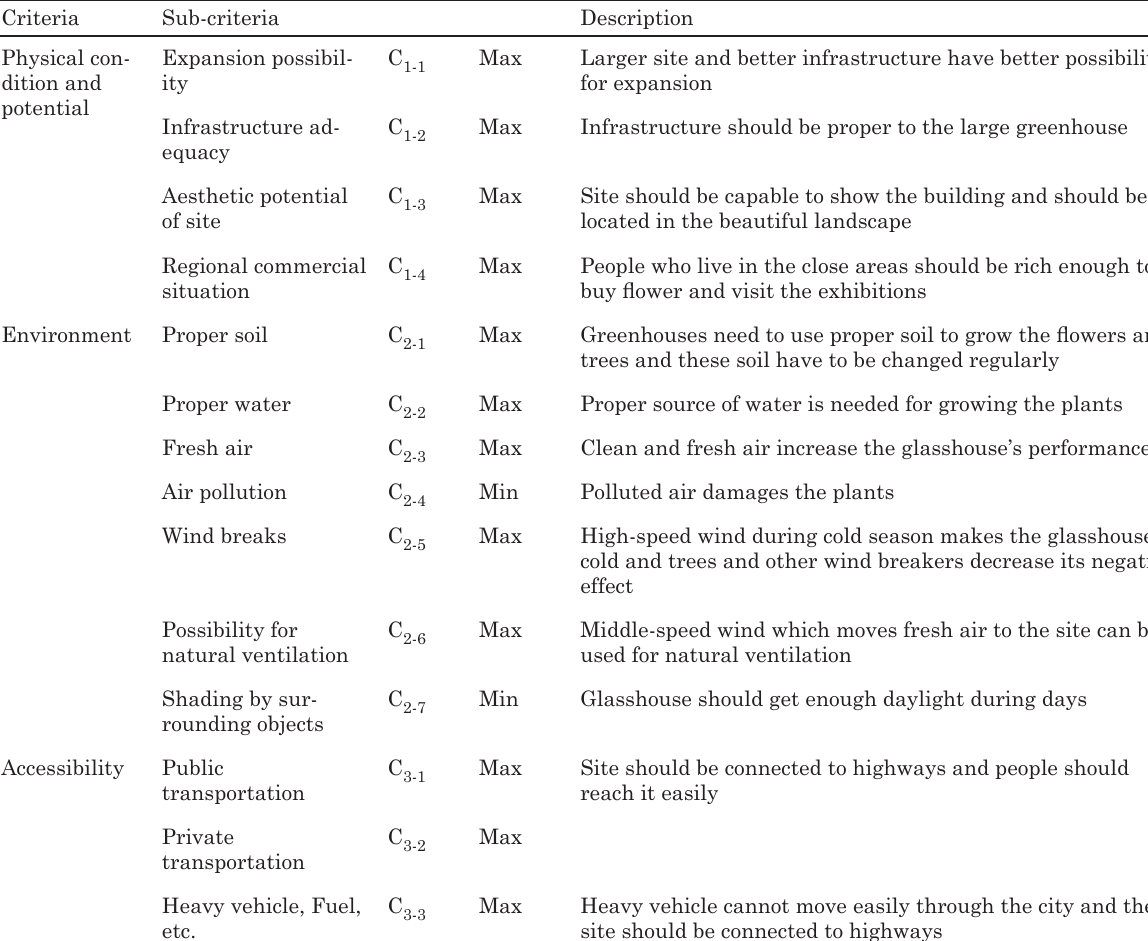
Table 2. Criteria and sub-criteria classification and